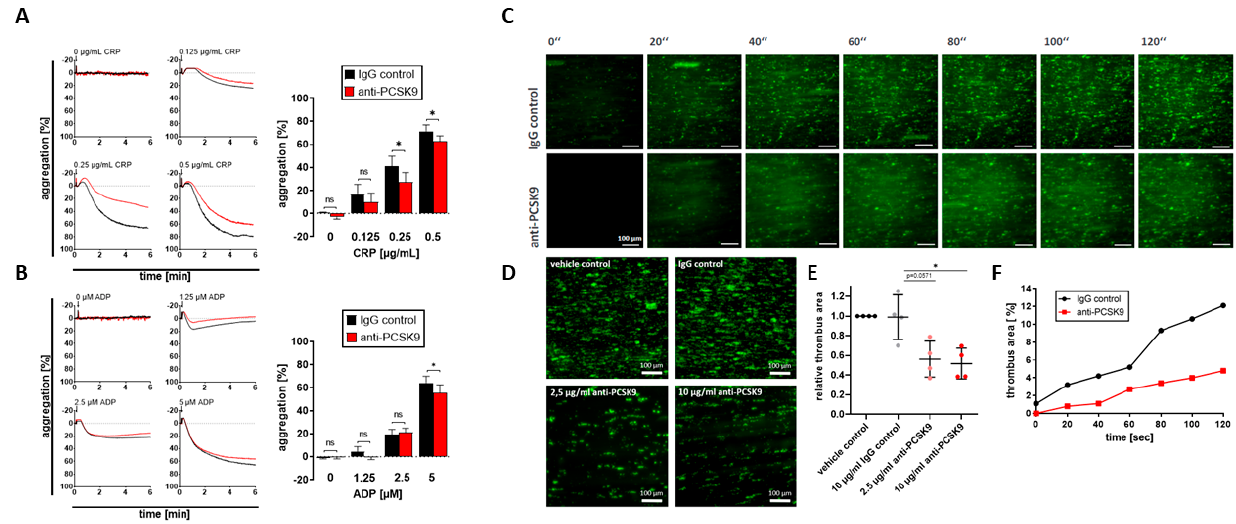
Figure 2. ( A ) Inhibition of PCSK9 decreased platelet aggregation. PRP was incubated with or without 15 µ g/mL anti-PCSK9 (evolocumab). The samples were stimulated with CRP (0.125 µ g/mL, 0.25 µ g/mL, 0.5 µ g/mL) or ADP (1.25 µ M, 2.5 µ M, 5 µ M) and platelet aggregation was measured by light transmission aggregometry. Representative CRP-induced platelet aggregation curves demonstrating the effect of anti-PCSK9 treatment on platelet aggregation. Statistical analysis revealed the percentage of aggregation was reduced by anti-PCSK9 treatment (plotted: mean ± SEM; n ≥ 3, Wilcoxon signed-rank test, ns = not significant, * p < 0.05). ( B ) Representative ADP-induced platelet aggregation curves demonstrating the effect of anti-PCSK9 treatment on platelet aggregation. Statistical analysis revealed that the percentage of aggregation was reduced by anti-PCSK9 treatment under stimulation with 5 µ M ADP (plotted: mean ± SEM; n ≥ 3, Wilcoxon signed-rank test, ns = not significant, * p < 0.05). ( C ) Anti-PCSK9 reduced platelet-dependent thrombus formation. Human whole blood was perfused over a collagen-coated surface (100 µ g/mL) at a shear rate of 1000 s − 1 . Representative fluorescence images of thrombus formation over time for n ≥ 3 independent experiments. (Scale bar = 100 µ m.) ( D ) Representative end-point fluorescence images for n ≥ 3 independent experiments. (Scale bar = 100 µ m.) ( E ) Statistical analysis of thrombus coverage showed a significant decrease of the thrombus area in whole blood samples treated with anti-PCSK9 antibodies compared to the IgG control and the vehicle control (plotted: mean ± SEM; n ≥ 3, Mann–Whitney test, * p < 0.05). ( F ) Thrombus formation over 120 s, measured in one representative